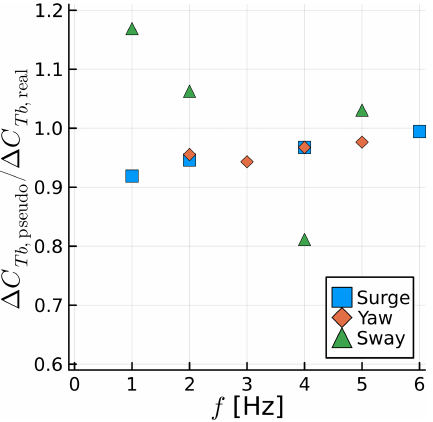
Figure 26. Ratio between amplitude of fluctuating blade thrust for pseudo-motion and real-motion simulations for various frequencies and motion types.